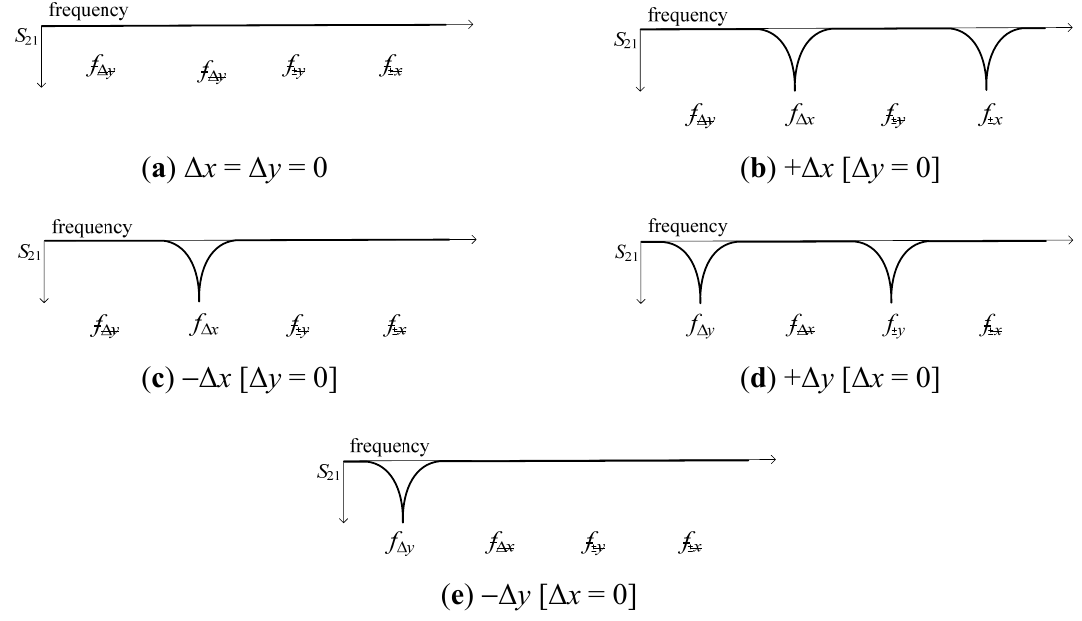
of the sensor for Δ x = 0.3 mm and Δ y = 0.25 21